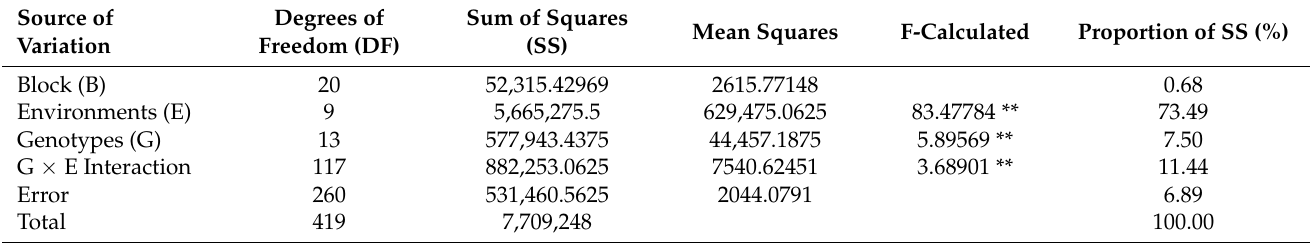
Table 3. Mean squares for hybrid grain yield under genotype by environment interaction study in